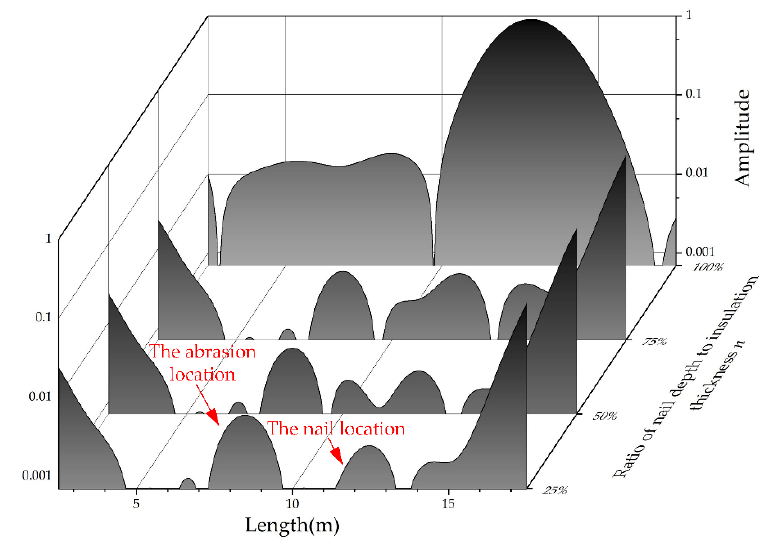
Figure 10. The location spectra of the cable samples with an inserted nail.